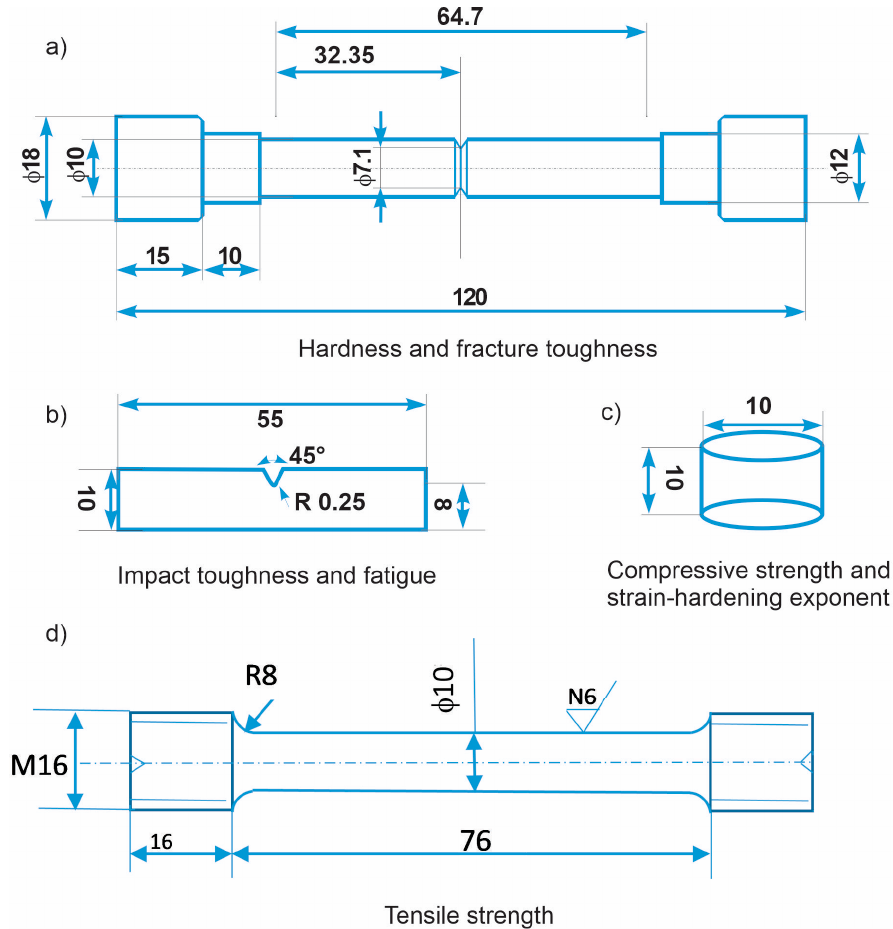
Figure 1 . Scheme of samples used for ( a ) hardness and fracture toughness, ( b ) impact